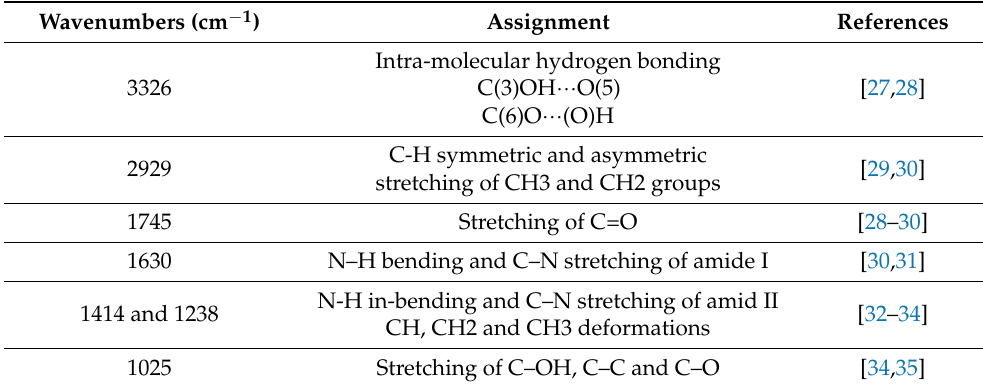
Table 2. IR assignments of the main vibrations in the FTIR spectra.